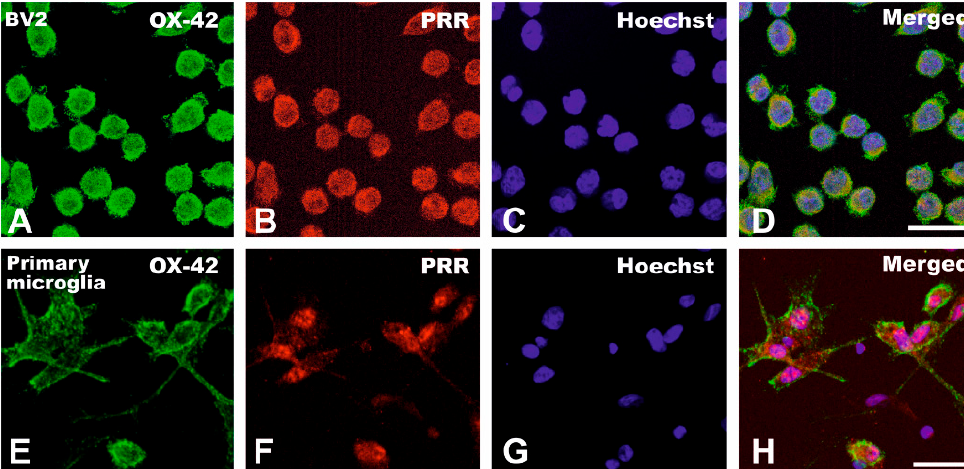
Figure 3. Double immunolabeling for the microglial marker OX-42 (green) and PRR (red) in BV2 microglial cells ( A – D ) and primary microglia ( E – H ). Scale bars for ( A – H ): 50 μ m. PRR, (pro) renin receptor.